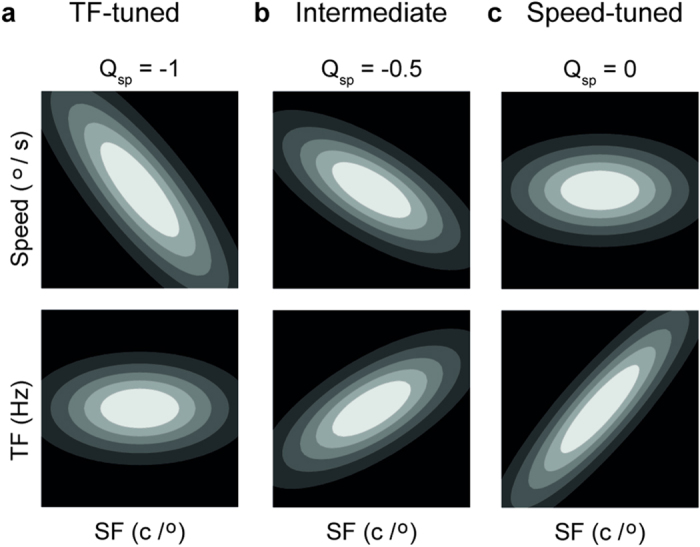
Schematic representations of the influence of parameter Qsp in tuning surfaces fitted with model R1.The Qsp parameter in the SF-speed inseparable model R1 allows the optimal speed to vary systematically with the SF of the stimulus. In this figure, the contours of the R1 model at 3 different levels of Qsp are illustrated. In the upper row, contours are plotted in the SF-speed coordinates (in log-log scale). In the lower row, contours are converted into the SF-TF coordinates. (a) For Qsp = −1, the optimal speed decreases with SF in a pattern that is consistent with perfect TF-tuning. (b) For −1 < Qsp < 0, the optimal speed decreases with SF, but at a rate lower than expected from a TF-tuned neuron. (c) For Qsp = 0, the optimal speed is independent with SF. This reflects a perfectly speed-tuned neuron.